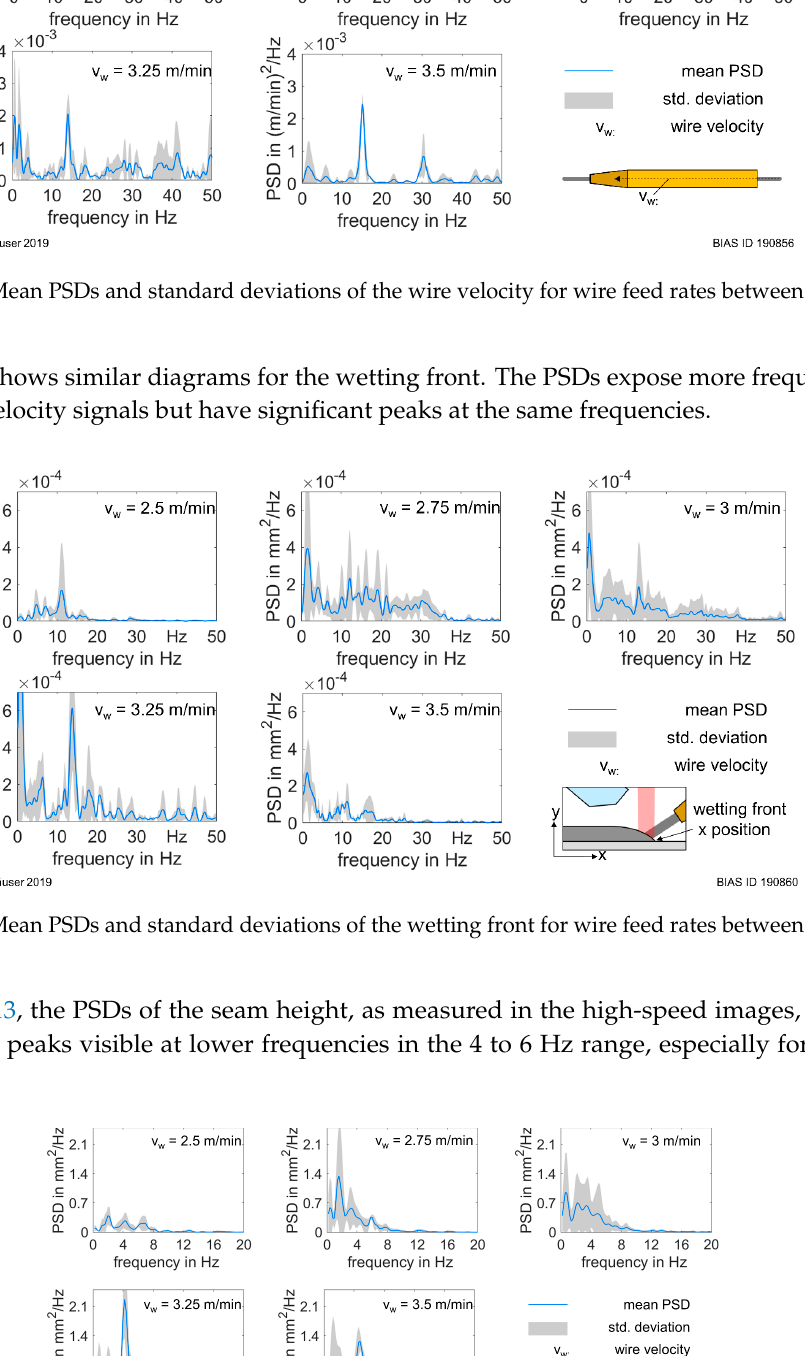
Figure 13. Mean PSDs and standard deviations of the seam height for wire feed rates between 2.5 and 3.5 m/min.